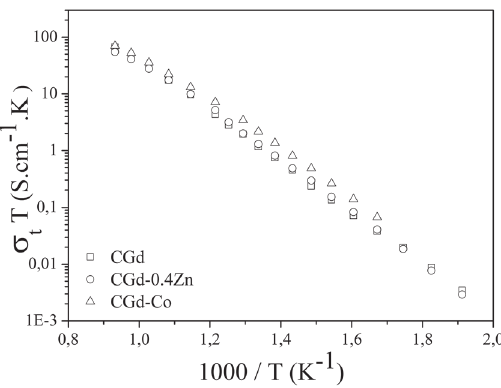
Figure 9: Arrhenius plots of total electrical conductivity measured in air of the samples sintered at 1200-1000